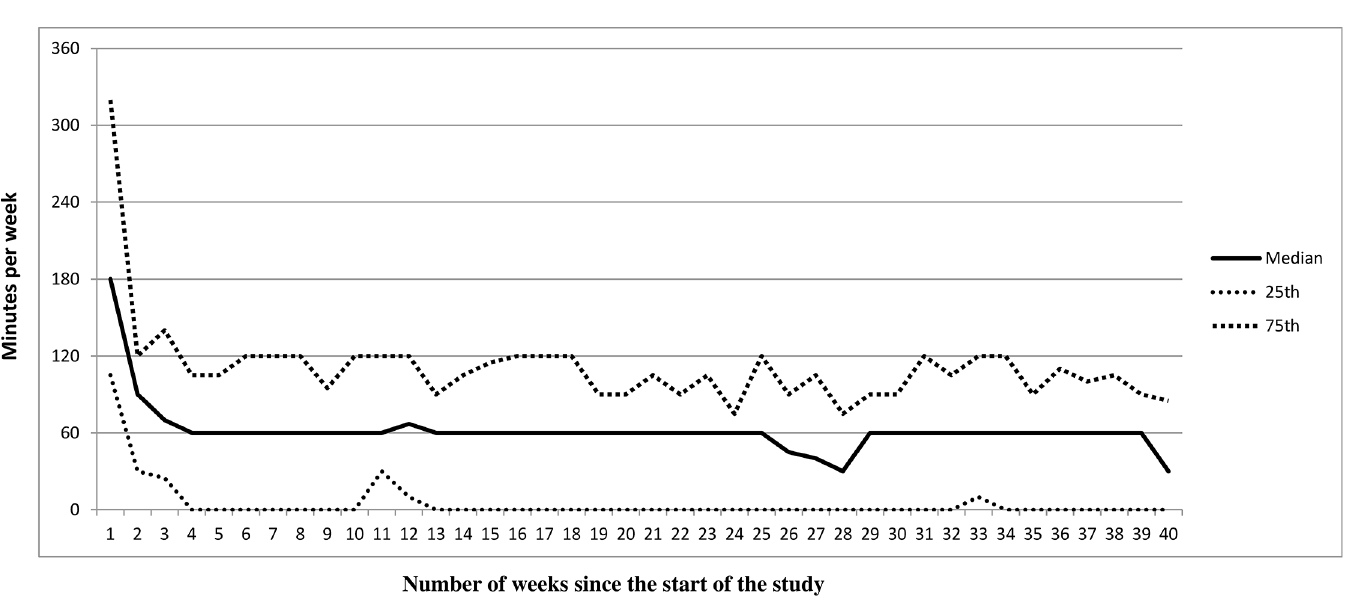
Fig 2. Development of usage of the Move games (minutes per week) over the 10-month (40 weeks) intervention